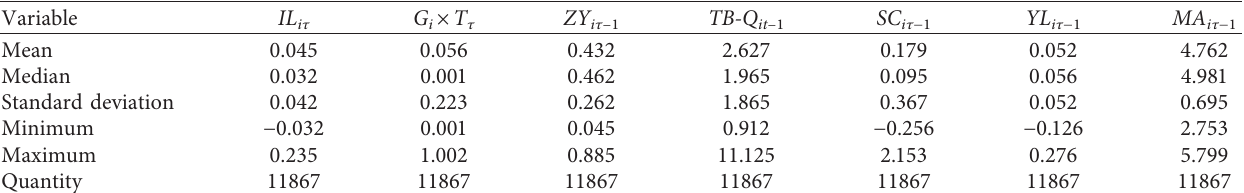
Table 3: Descriptive statistics for the model of the relationship between green financing and green enterprise investment level.